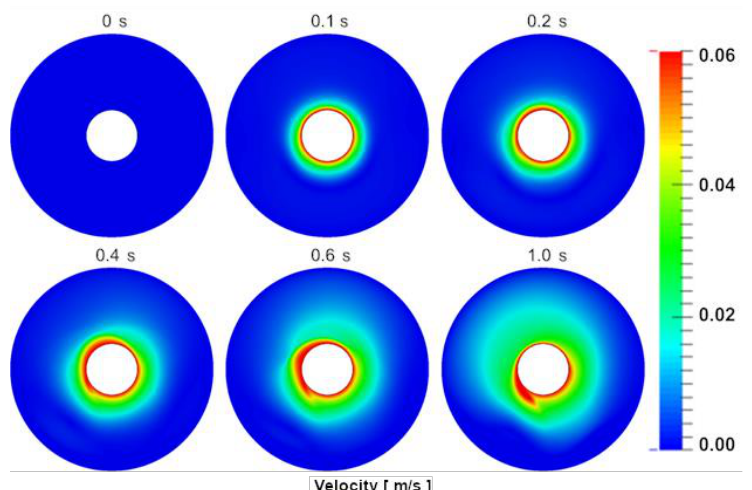
Figure 9. Velocity field at different time steps predicted by the proposed particle flux model.